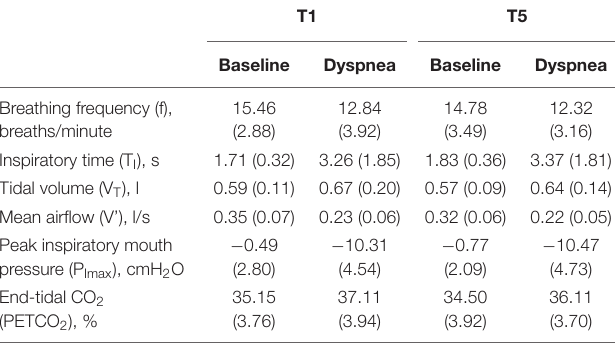
TABLE 3 | Means ( SD ) of respiratory variables for each condition for T1 and T5.